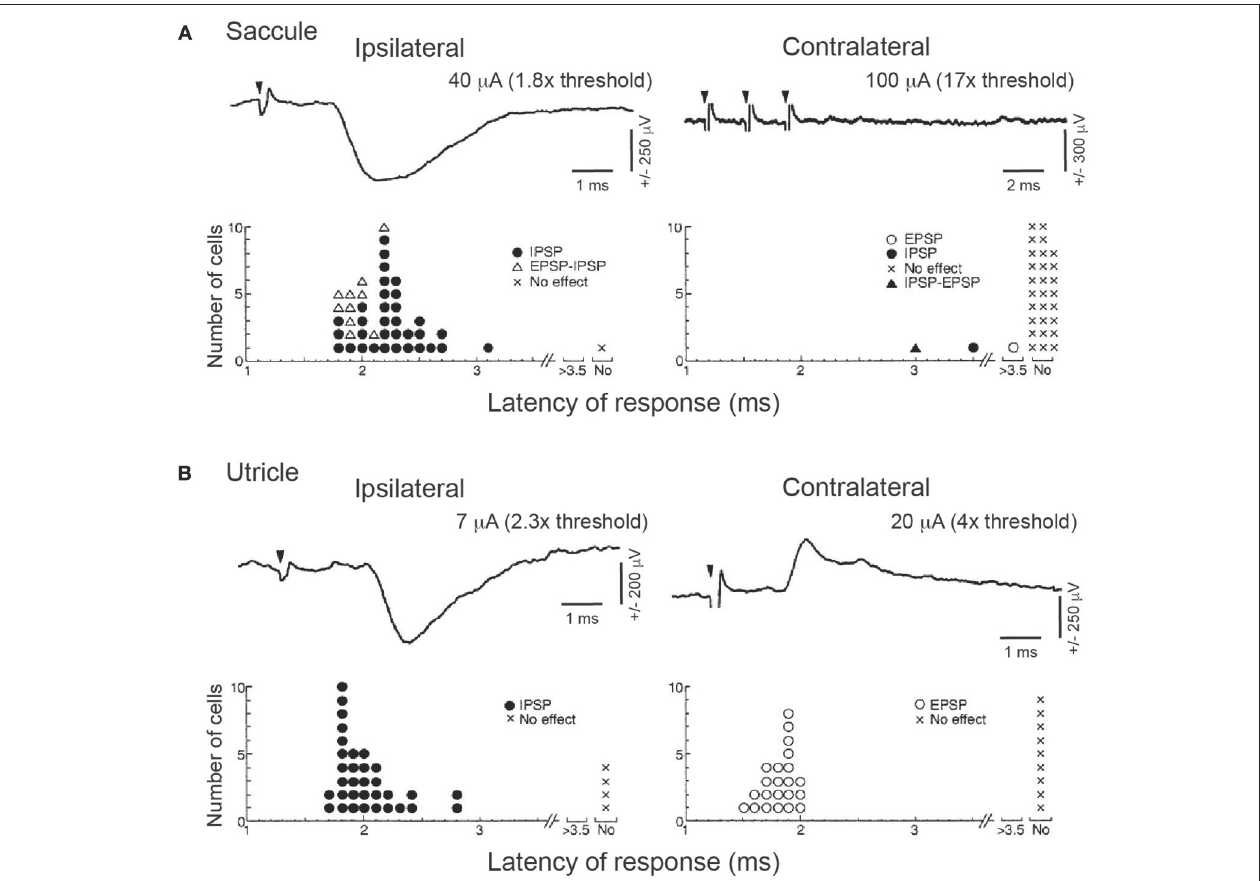
FIGURE 3 | Effects of saccular (A) or utricular (B) stimulation on ipsilateral or contralateral SCM motoneurons recorded intracellularly. Upper rows of (A) and (B) show typical waveform or IPSPs (upper left) or EPSPs (upper right of B ) evoked by selective nerve stimulation; note the absence of any effect following even three pulses of saccular stimulation (downward filled triangles show time of stimulation pulses). Stimulation currents relative to nerve threshold. Lower rows of (A) and (B) show histograms summarizing response type and response latency across all recordings, emphasizing the selective ipsilateral effect of saccular stimulation and the bilateral effect of utricular stimulation. Reproduced from Kushiro et al. (51), with permission from Springer Nature.